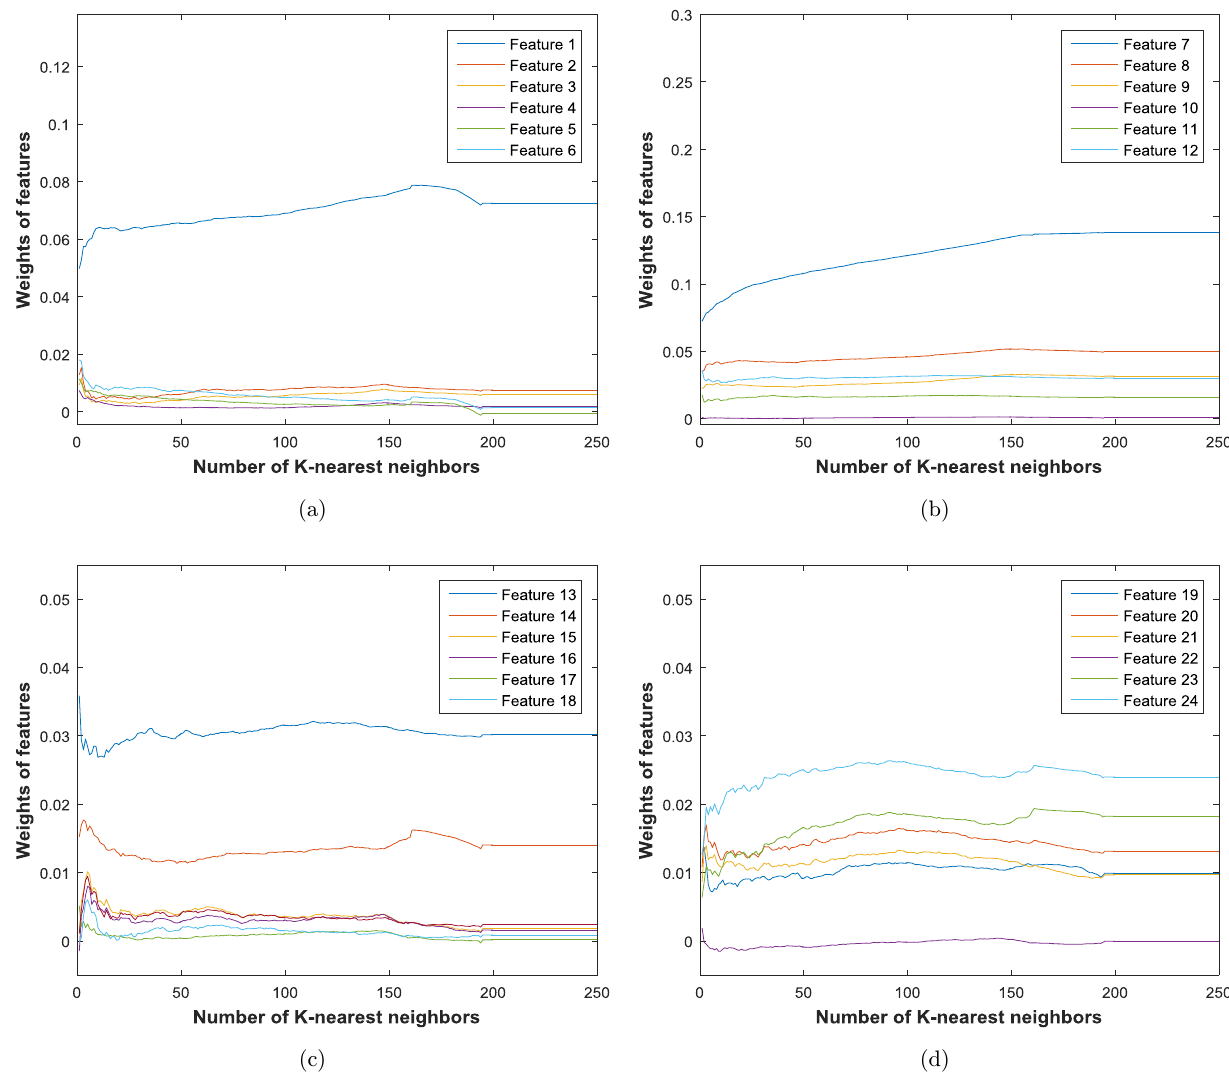
Fig. 14. Weights of ¯rst 24 features varying as number of neighbors are increased from 1 to 250 by Relief-F algorithm (for local database). (a) Values of feature weights from 1 to 6, (b) Varying weights of features from 7 to 12, (c) Varying weights of features from 13 to 18 and (d) Varying weights of features from 19 to